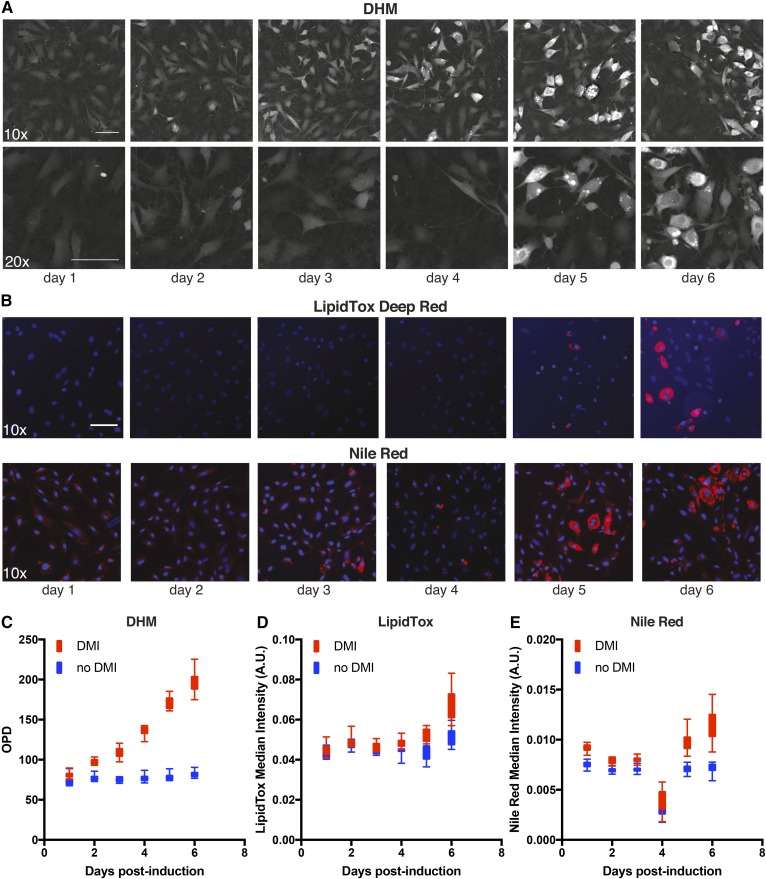
Six-day time lapse of OP9 cells induced to differentiate toward adipocytes: Comparison of DHM and fluorescence microscopy. A: DHM images from day 1 to 6 postplating and induction. Top, 10× bottom, 20×. B: Fluorescence images taken from day 1 to 6 postplating and induction. Blue is Hoechst 33342, and red is either LipidTox Deep Red (top) or Nile Red (bottom). C: OPD values of OP9 cells induced to differentiate (red) versus noninduced OP9 cells (blue). D, E: LipidTox Deep Red and Nile Red median signal intensities in both induced and noninduced OP9 cells. Note the error during the Nile Red staining procedure on day 4 postinduction of adipocytic differentiation. R2 = 0.6 for OPD vs. LipidTox Deep Red and R2 = 0.54 for OPD vs. Nile Red. Error bars are SD. Scale bars = 100 μm.